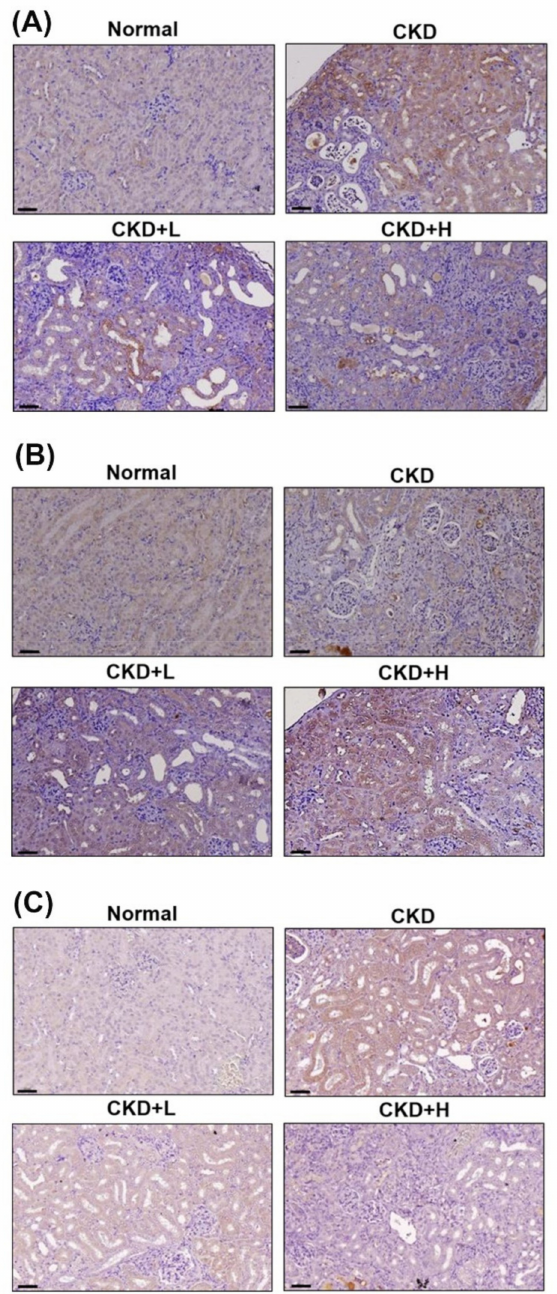
Figure 6. Phosphoramidon regulates ER stress, autophagy and the NLRP3 inflammasome in the adenine diet-induced CKD model. The protein expression of IRE1 α ( A ), LC3 ( B ) and NLRP3 ( C ) in kidney sections in the indicated groups. Scale bar = 60 µ